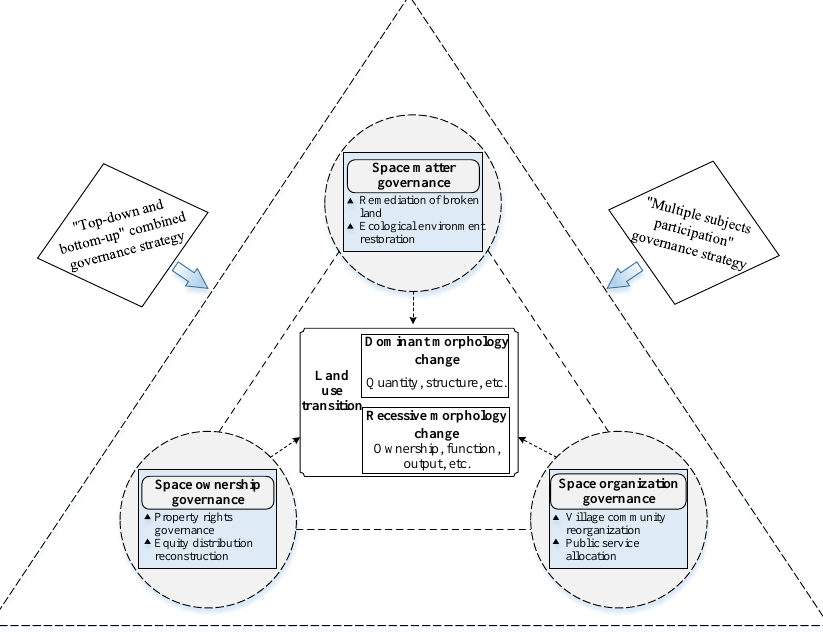
Figure 3. Analysis framework of rural industrial land transition oriented by space governance.